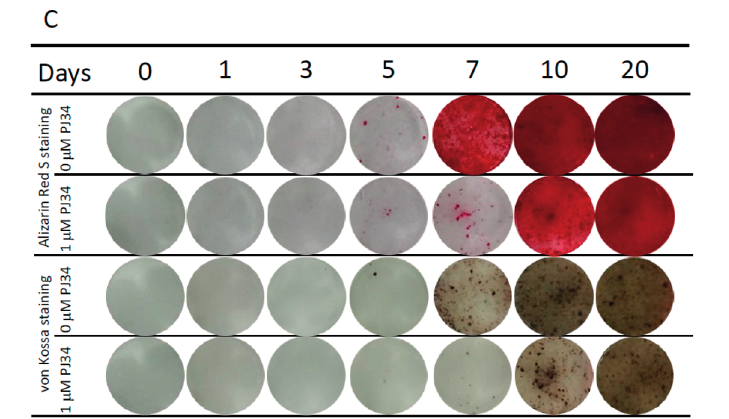
Figure 5. Effects of PJ34 on osteogenic differentiation of KUSA-A1 cells were also analyzed by Alizarin Red S staining ( A ) and von Kossa staining ( B ); ( C ) Representative photos of Alizarin Red S staining and von Kossa staining of KUSA-A1 cells during osteogenic differentiation. Values are expressed as mean ± SEM. A.U. = Arbitrary Unit. * p < 0.05, ** p < 0.01.